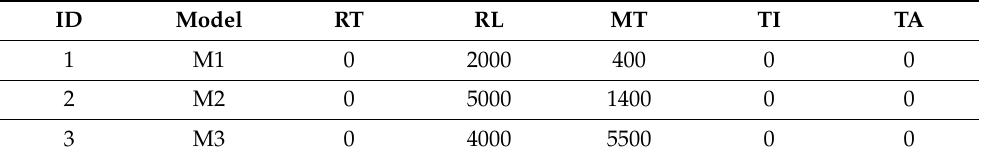
Table 8. AAV unit parameters.